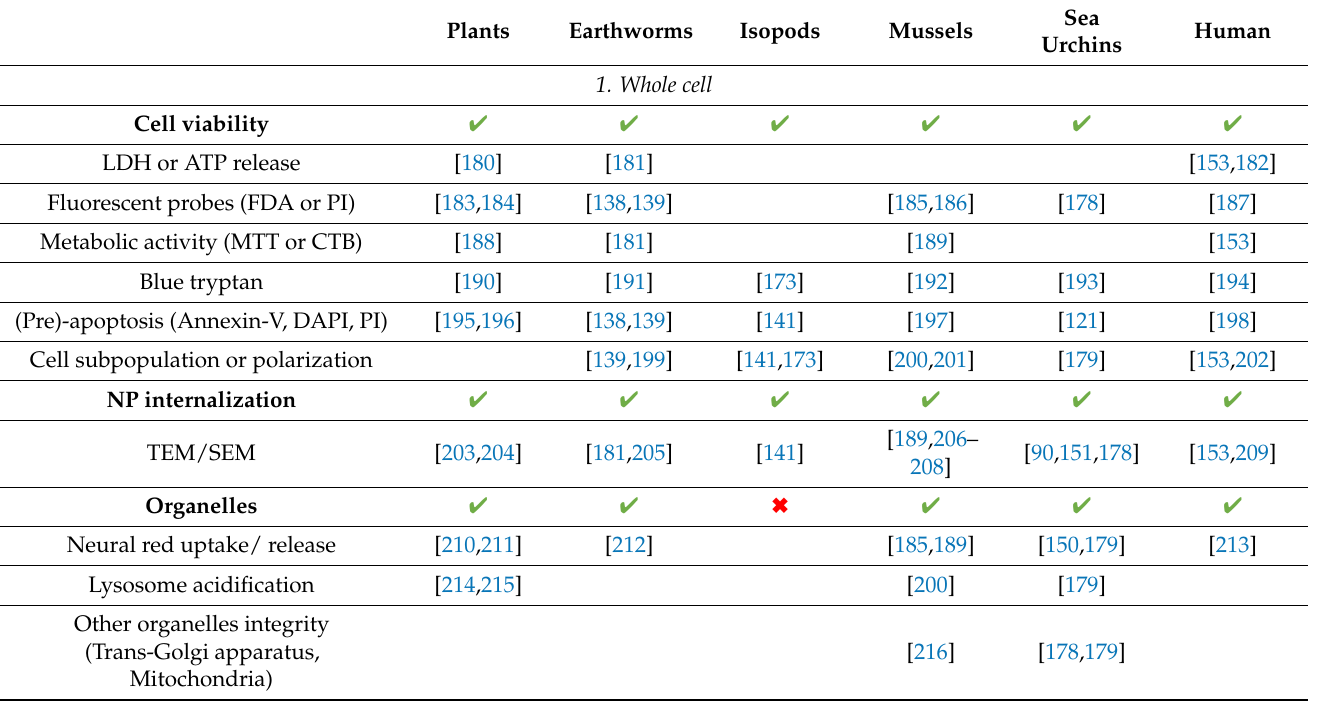
Figure 7. Summary of the different endpoints measured in immune cells after exposure to NPs. Table 2. Overview of studies demonstrating the use of cellular and humoral parameters to characterize the immune responses of organisms.